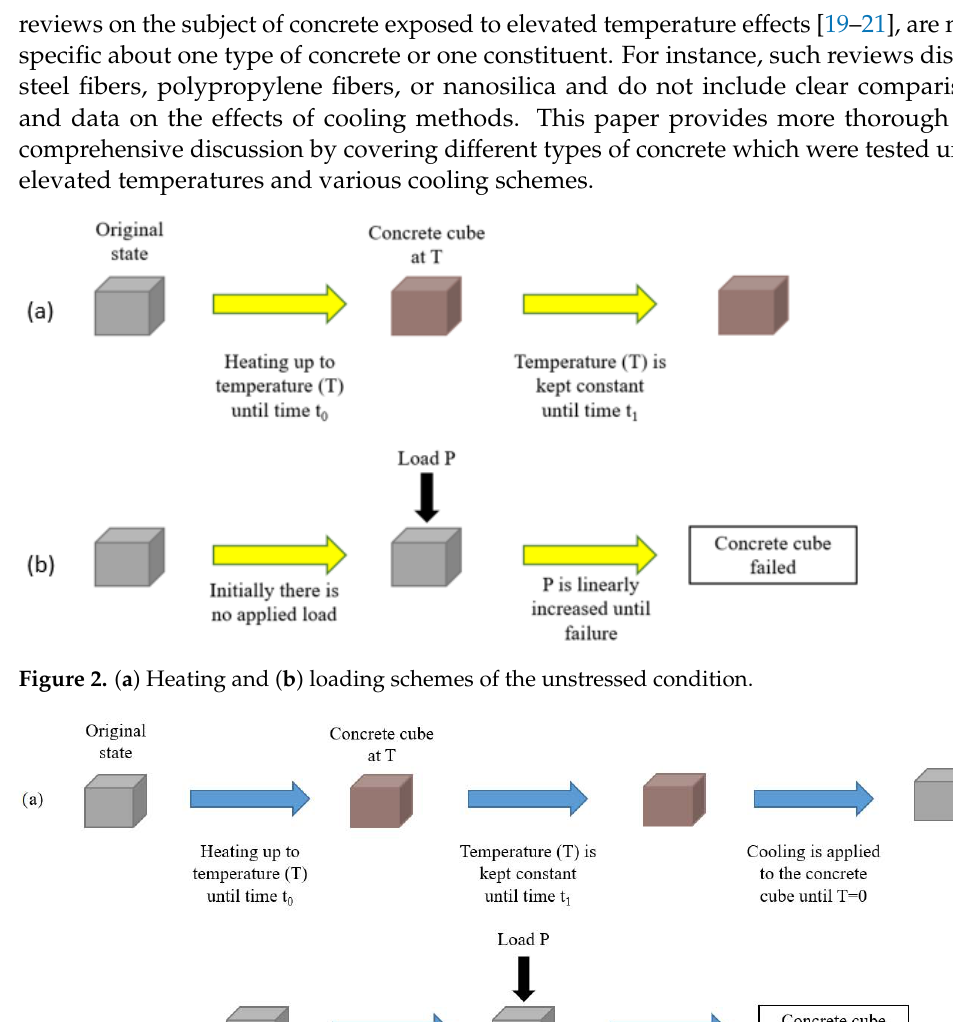
Figure 3. ( a ) Heating and ( b ) loading schemes of the residual